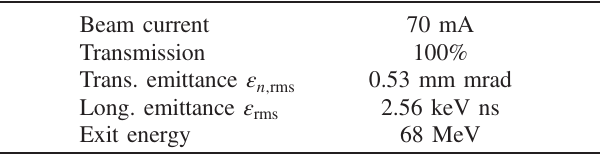
TABLE III. Beam output parameters of the 65 MV proton linac.